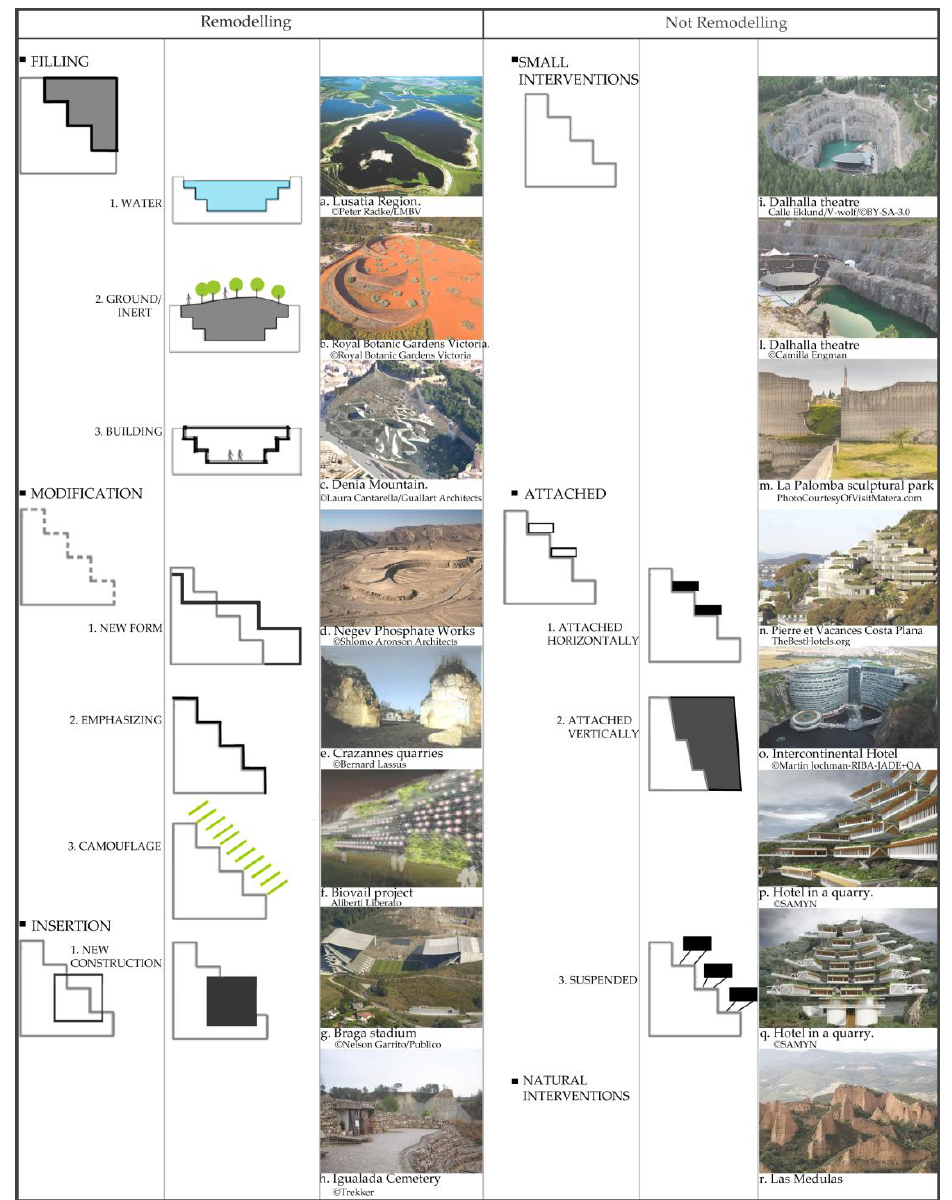
Figure 4. Matrix of schemes of different and existing recovery typologies for quarries (partially elaborated from [4]).